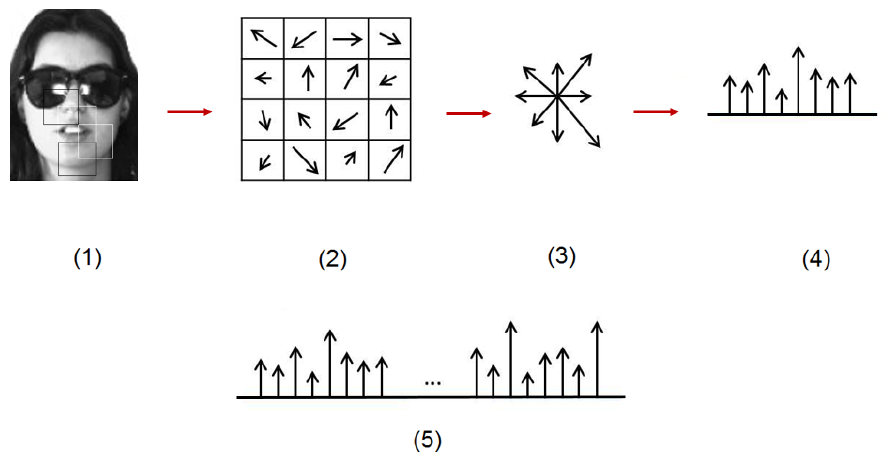
Figure 5. The process of extracting HOG features from face images: (1) Original face image after patching (2) partition of each patch into cells (3) extraction of HOG features from each cell (4) Concatenation of HOG features of each cell (5) Concatenation of HOG histograms of all cells into a single